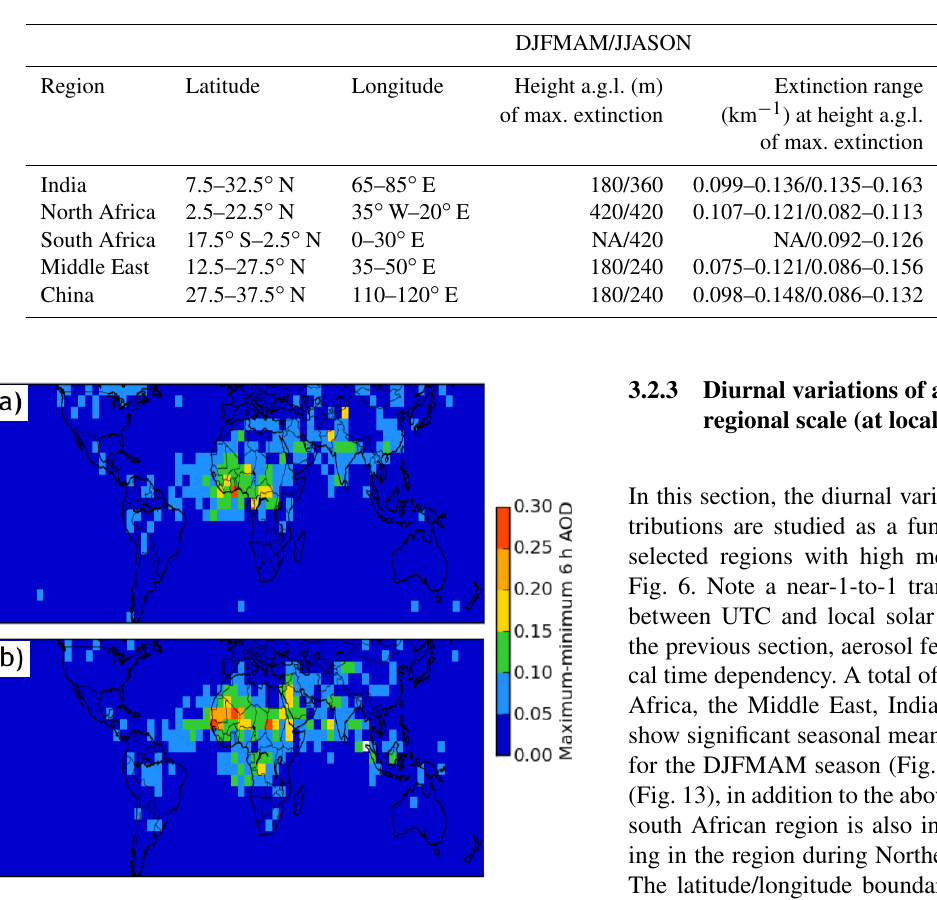
Figure 9. Maximum minus minimum mean seasonal AOD (1064nm) for (a) DJFMAM and (b)